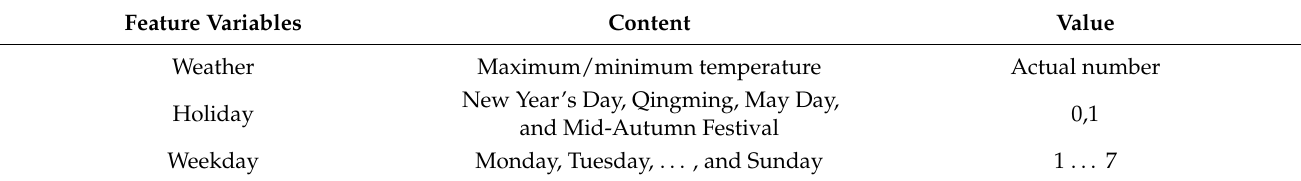
Table 5. Feature variables of the prediction model for the second highest load rate.